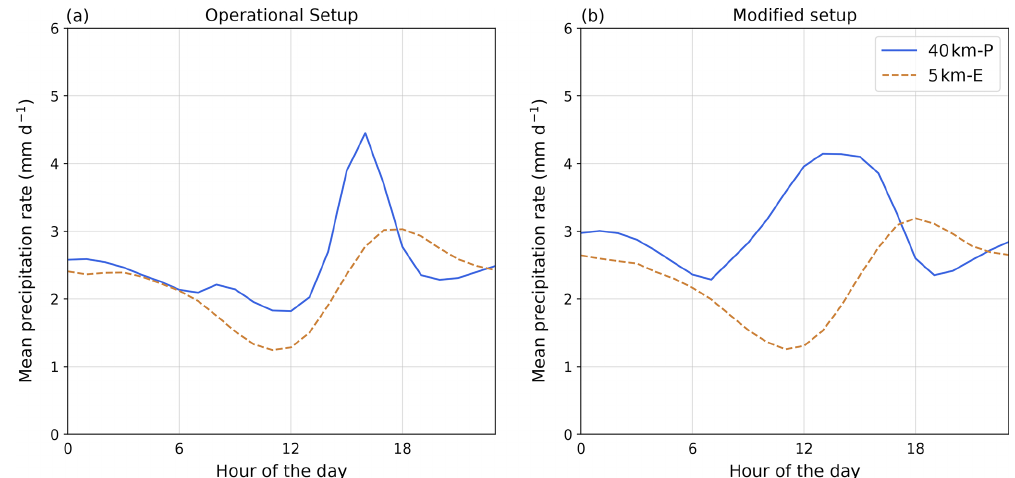
Figure 3. Mean diurnal cycle of precipitation for the 40km-P (solid blue) and the 5km-E (dashed orange) simulation for July to September (JAS). (a) The diurnal cycle for the operational ICON-NWP model; (b) the diurnal cycle of the modified ICON-NWP setup used in Sect. 3.6. The diurnal cycle is calculated over the dashed “WA domain” outlined in Fig. 1.